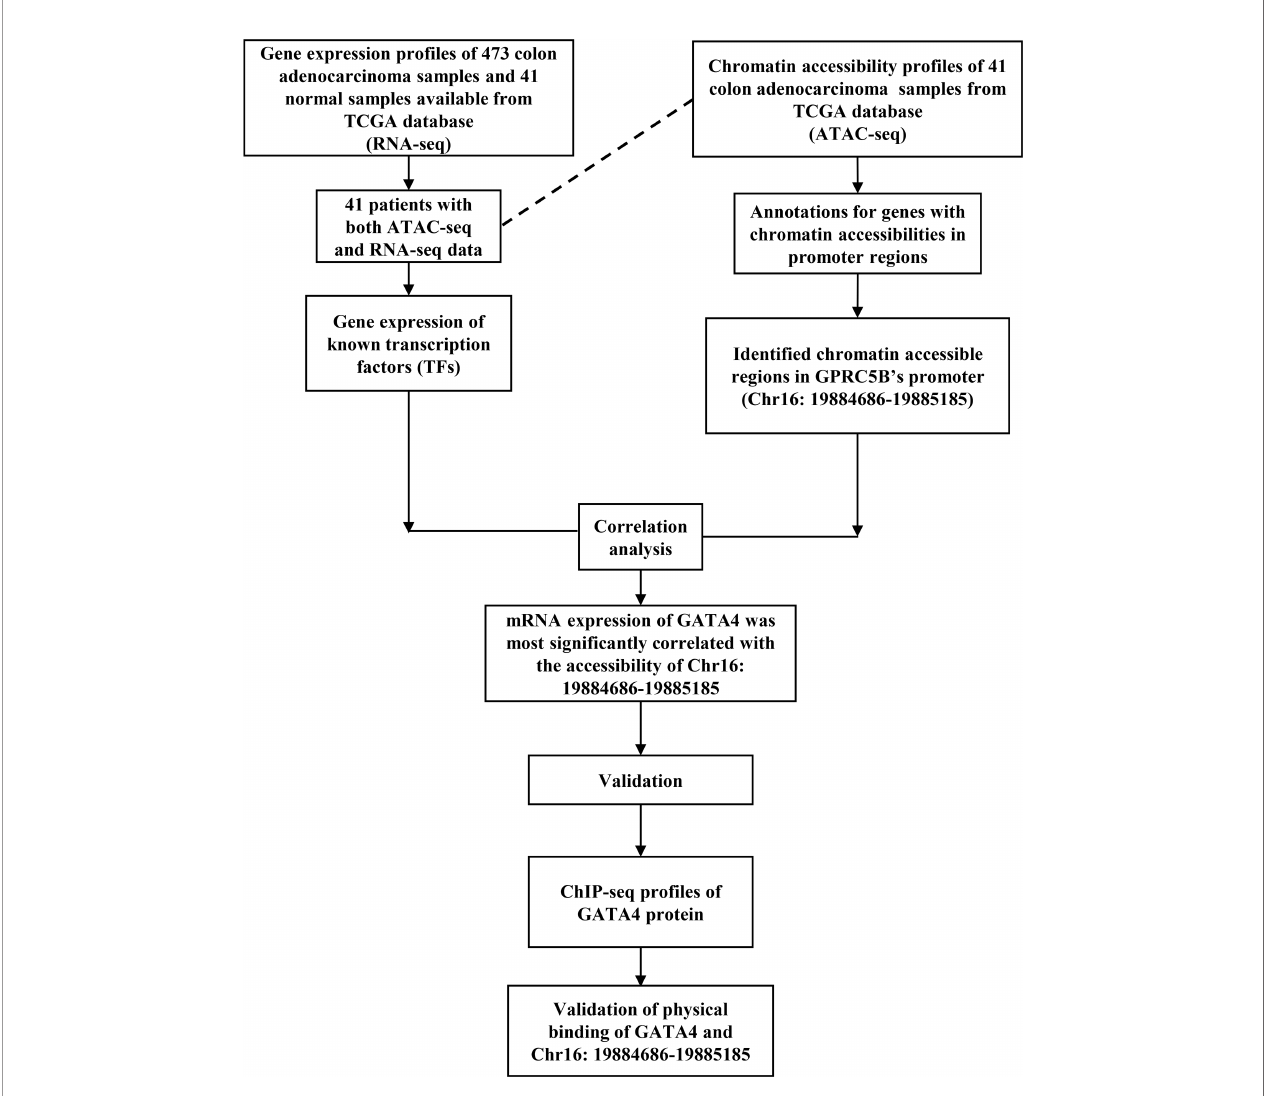
FIGURE 1 | An overview of the novel pipeline of our